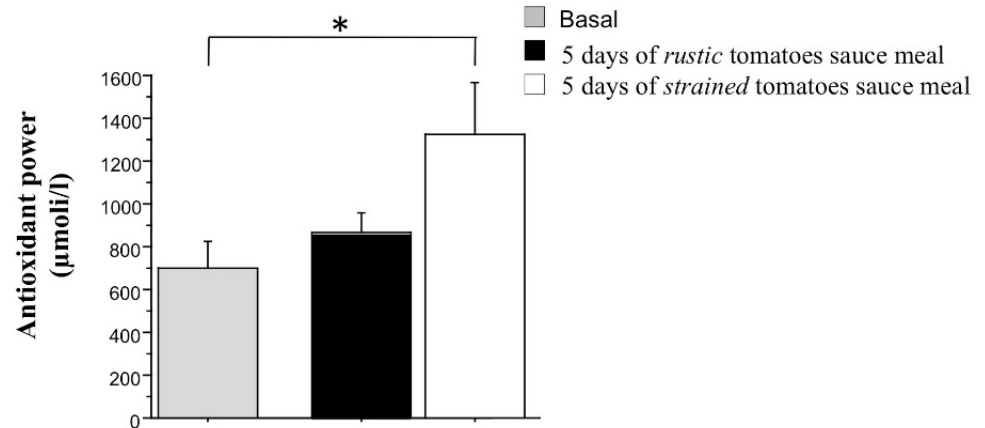
Figure 4. Biological antioxidant potential (BAP) detected as power associated to the ability of plasma barrier components to give reducing equivalents to reactive species in the plasma of subjects after 5 days consumption of the two sauces vs. basal BAP. Bars represent the mean ± SD of lycopene isoform concentration after 5 days of rustic tomatoes sauce (black bars) and strained tomatoes sauce (white bars) consumption vs. basal withdrawal in basal conditions * p <